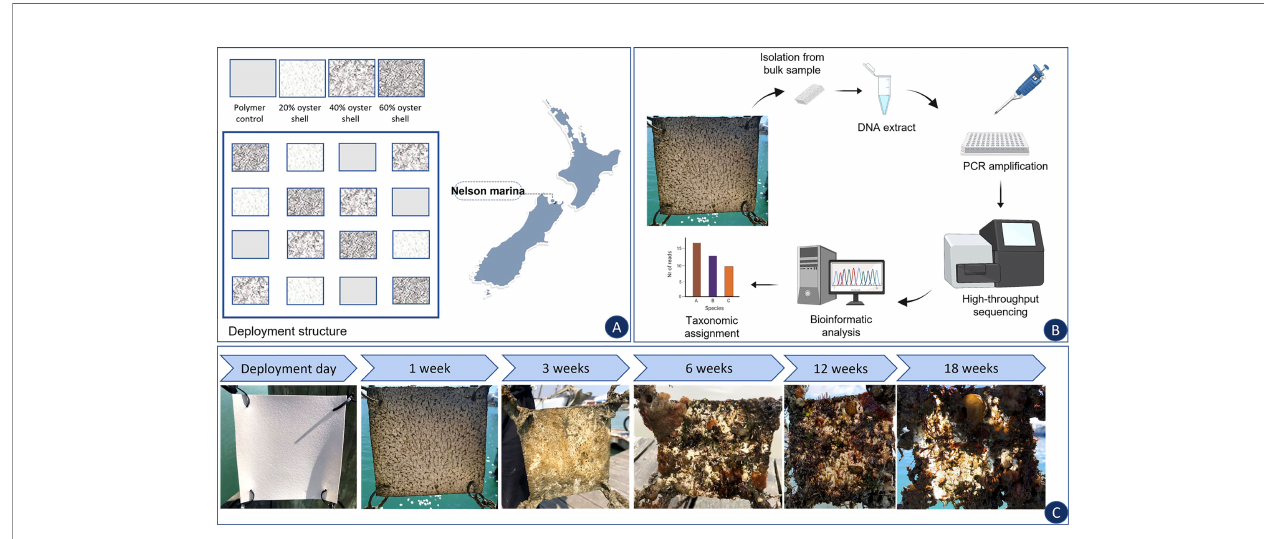
FIGURE 1 | Experimental design and study location. (A) In total, three PVC frames with 12 bio-polymers sheets, comprising four polybutylene succinate (PBS) control sheets, four PBS sheets enriched with 20% of oyster shell fi ller, four PBS sheets enriched with 40% of oyster shell fi ller, and four PBS sheets enriched with 60% of oyster shell fi ller were deployed alongside fl oating pontoon at the study location; (B) Sample processing as described in section 2.3; (C) Sample collection with established sampling time ( Figure 1A ): ( i ) OYS20 – PBS containing 20% of oyster shell content; ( ii ) OYS40 – PBS containing 40% of oyster shell; ( iii ) OYS60 - PBS containing 60% of oyster shell; ( iv ) Control-PBS